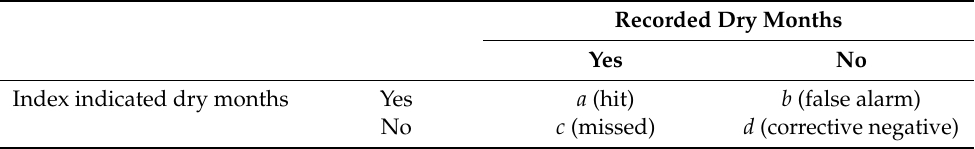
Table 4. Contingency table used in the calculation of the probability of detection and false alarm rate.